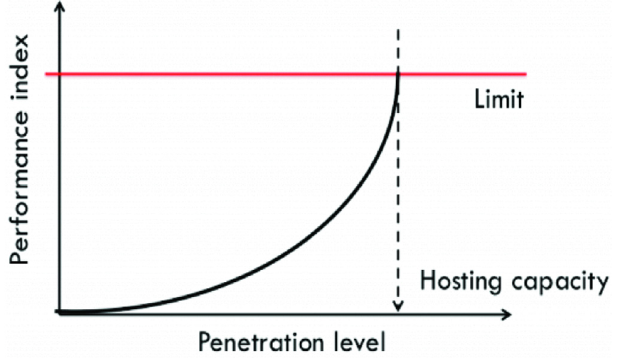
Figure 1. The HC